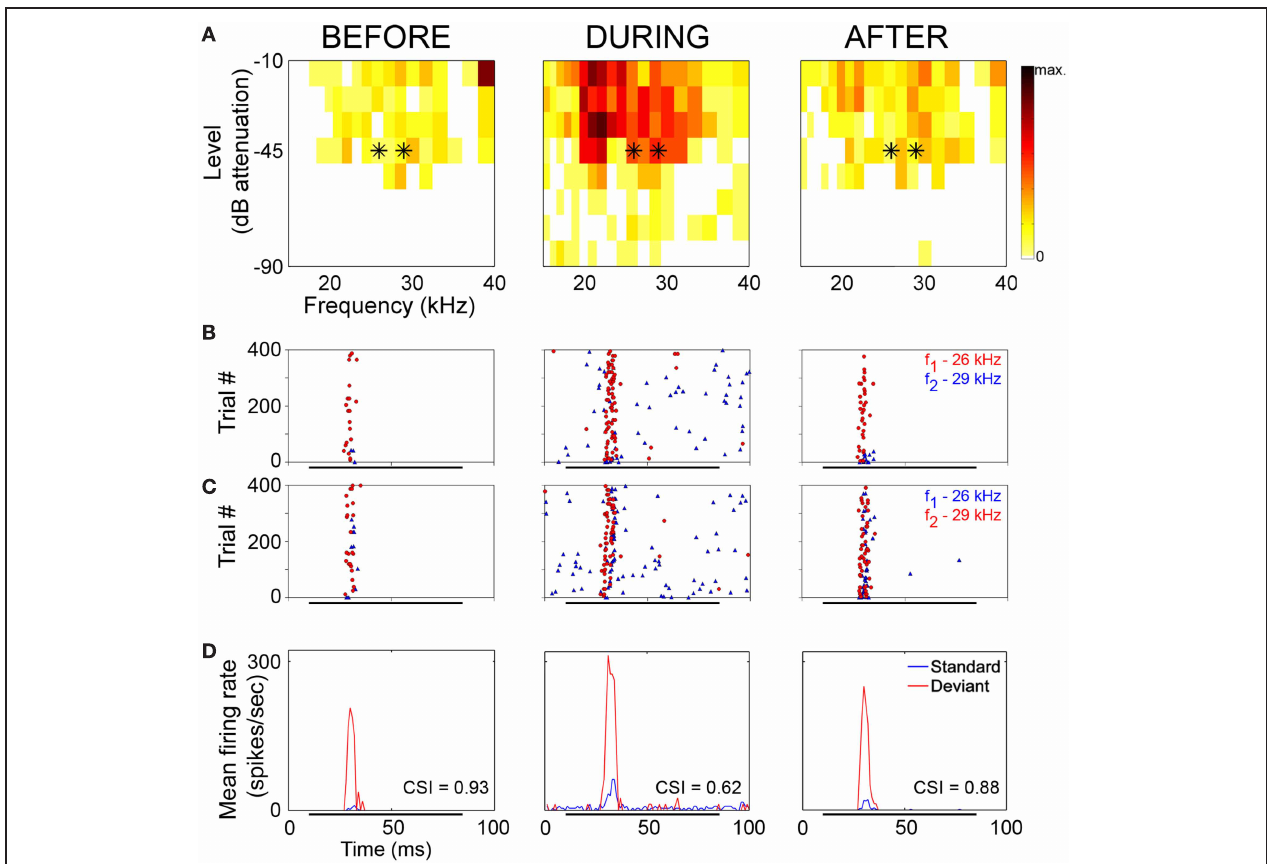
frequency) as deviant (red circles) and f 2 (higher frequency) as standard (blue triangles). (C) Raster plots showing response to f 1 as standard (blue triangles) and f 2 as deviant (red circles). (D) PSTH showing mean response to standard (blue) and deviant (red) stimuli. CSI values for each period are superimposed onto the relevant PSTH. Reproduced from Anderson and Malmierca